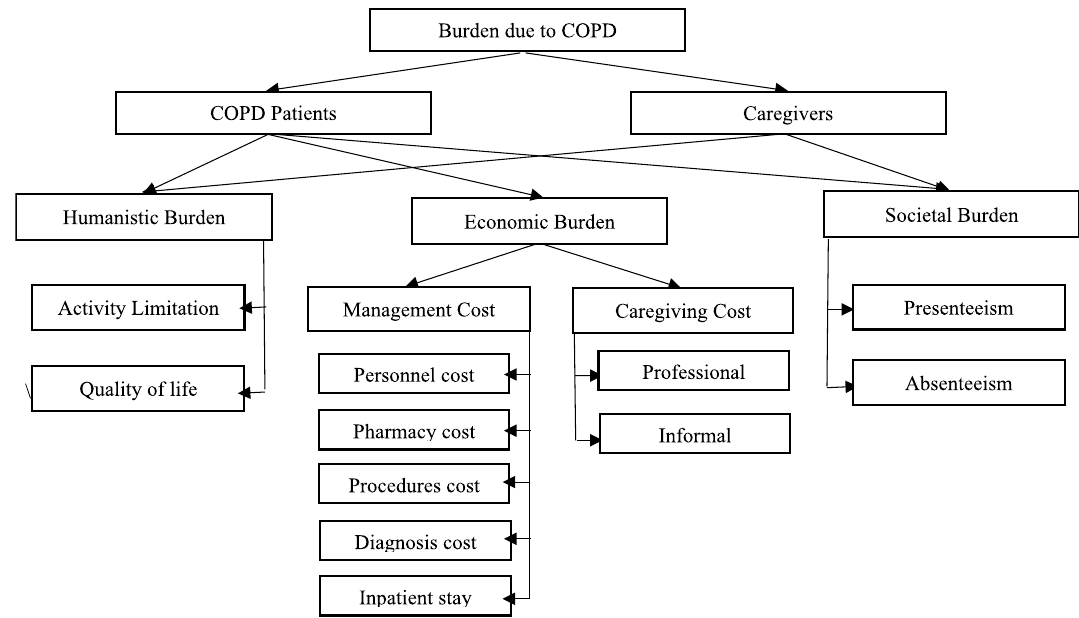
Figure 1. Humanistic, economic and societal burden due to COPD on patients and their